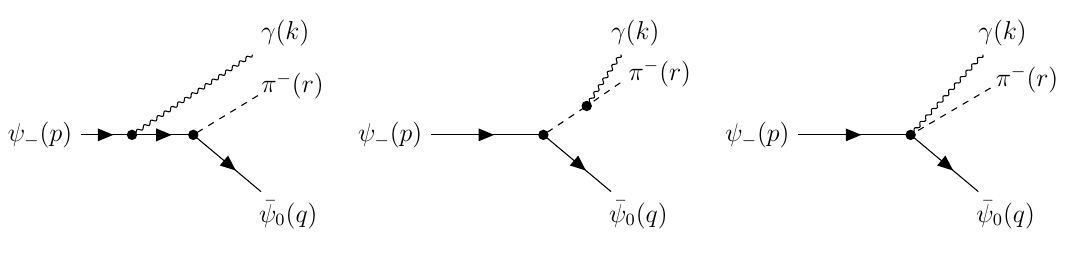
Figure 15 . The real photon emission associated to the Wino